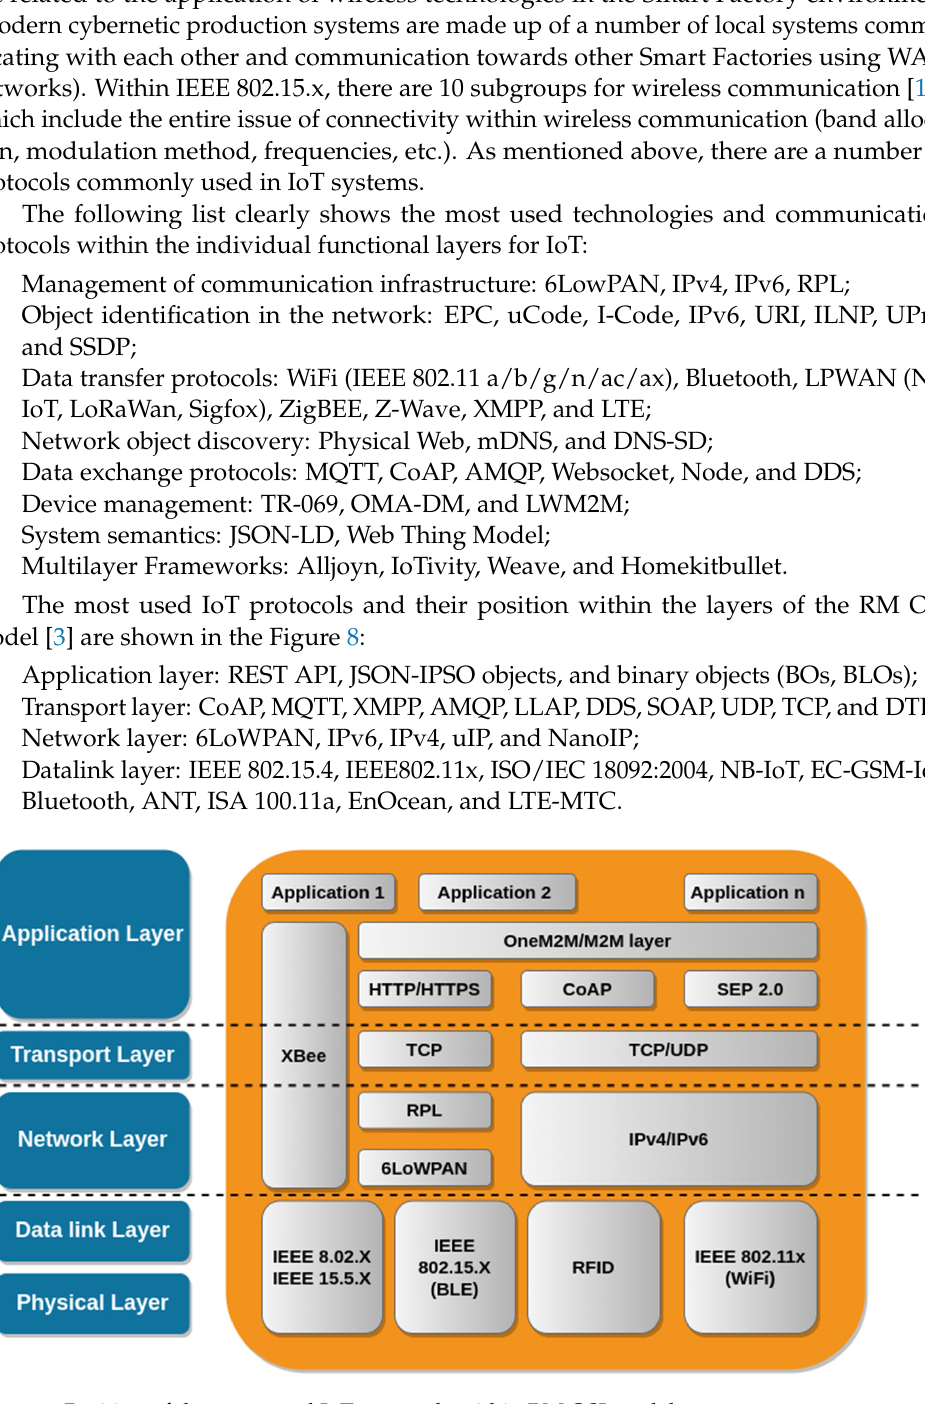
Figure 8. Position of the most used IoT protocols within RM OSI model.